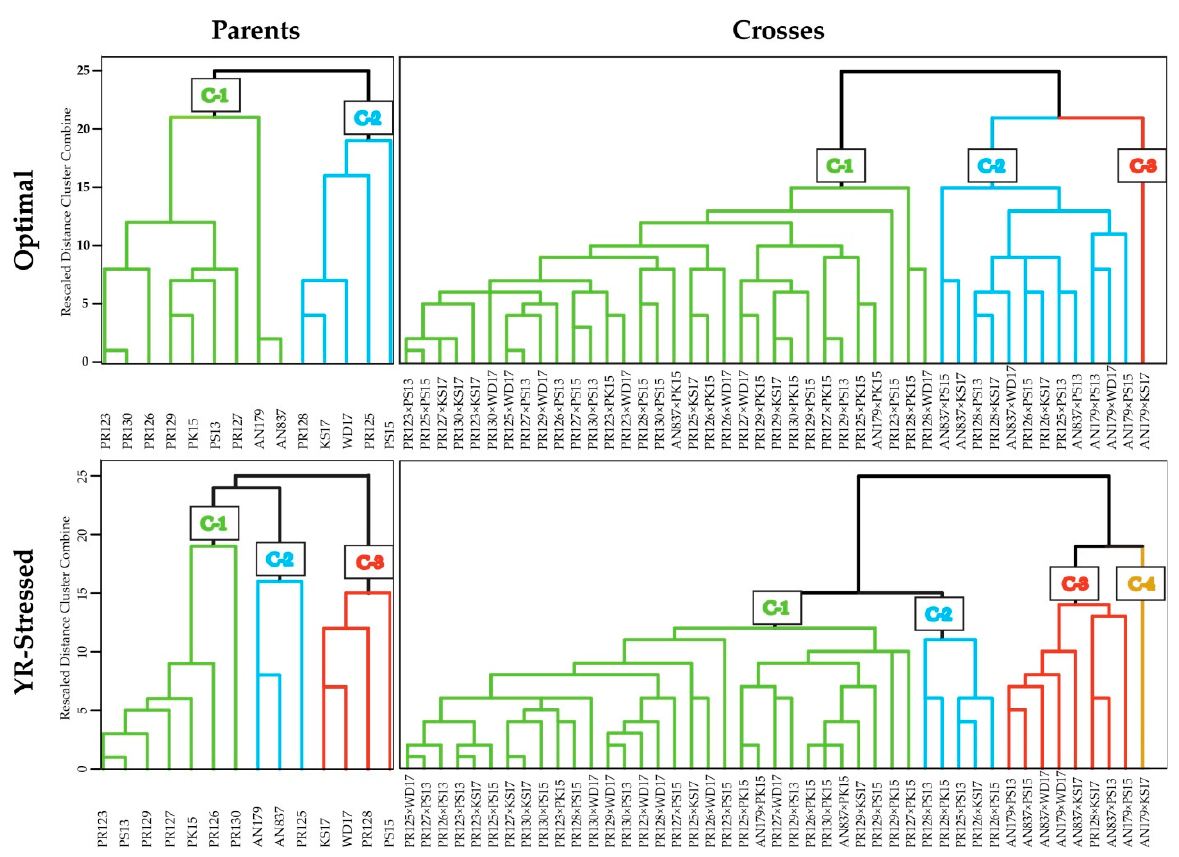
Figure 2. Phylophenetics analysis of the parents and crosses under optimal and YR-stress using different morphological, yield component traits and physiochemical parameters.